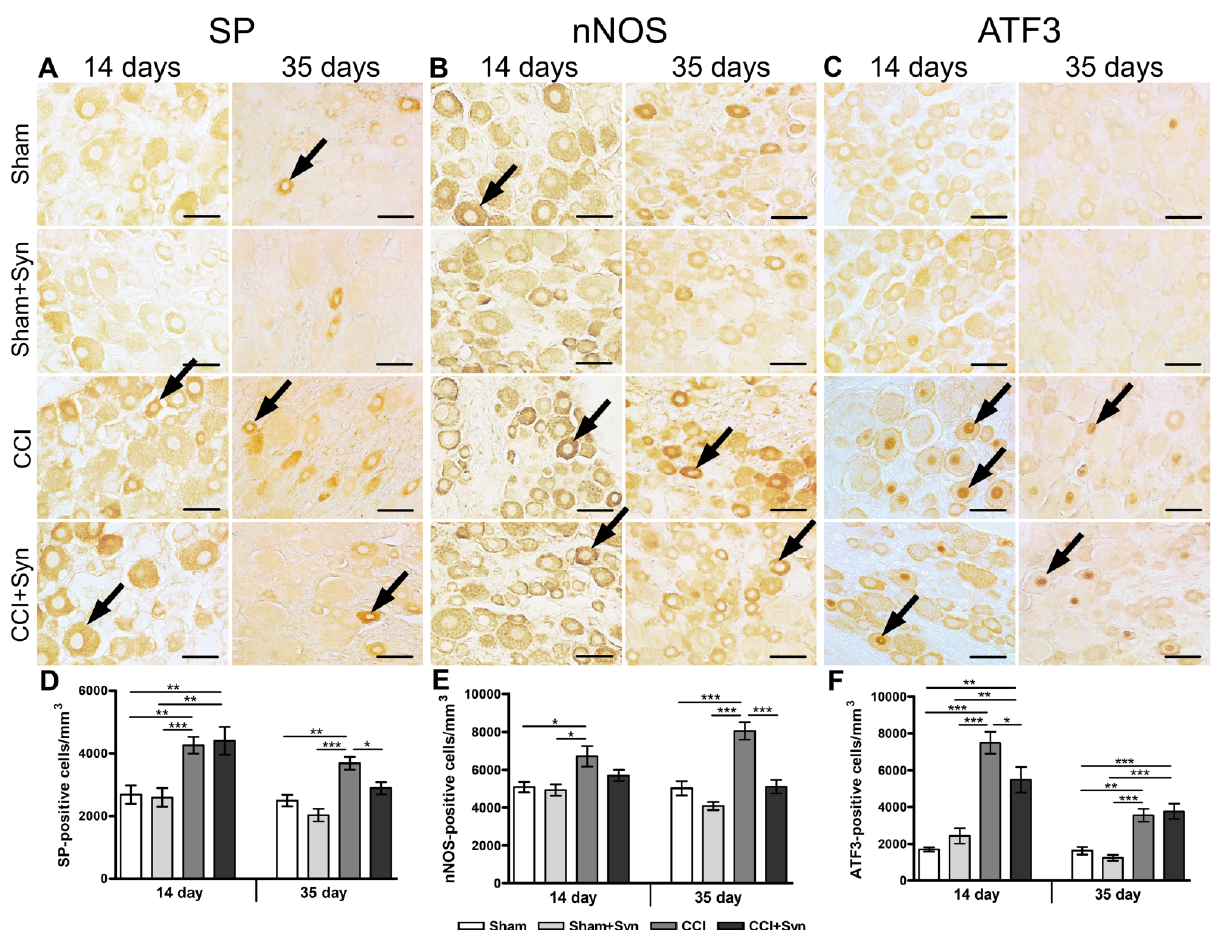
Figure 6. Representative images of (( A ), black arrows) substance P- (SP-), (( B ), black arrows) neuronal NO-synthase- (nNOS-), and (( C ), black arrows) activating transcription factor 3- (ATF3-) positive neurons in the DRG. Scale bar is 50 µm. ( D ) The number of SP-positive neurons within the DRG, mean ± SEM, n = 7 (number of animals/group) * p < 0.05, ** p < 0.01, *** p < 0.001 (one-way ANOVA, post-test Tukey). ( E ) The number of nNOS-positive neurons within the DRG, mean ± SEM, n = 7 (number of animals/group) * p < 0.05, *** p < 0.001 (one-way ANOVA, post-test Tukey). ( F ) The number of ATF3-positive neurons within the DRG, mean ± SEM, n = 7 (number of animals/group) * p < 0.05, ** p < 0.01, *** p < 0.001 (one-way ANOVA, post-test Tukey). “Sham”—sham-operated animals that received vehicle treatment; “Sham + Syn”—sham-operated rats that underwent synaptamide administration; “CCI”—animals with chronic constriction injury of the sciatic nerve that received vehicle treatment; “CCI + Syn”—synaptamide-treated rats with chronic constriction injury of the sciatic nerve that underwent synaptamide treatment.